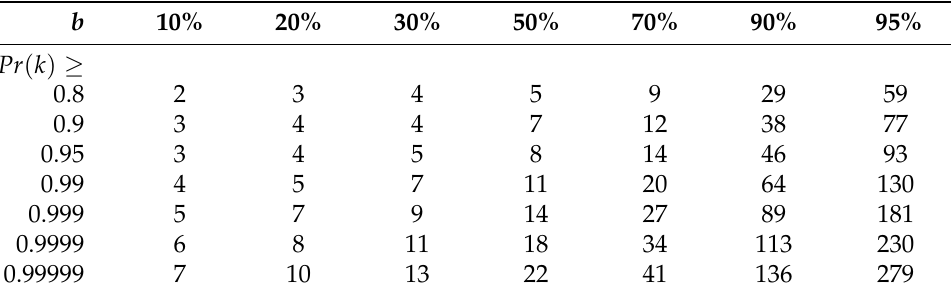
Figure 4. The Probability Pr ( k ) for different percentages of corrupt parties. Table 3. Minimal values of k for desired Pr ( k ) according to b .